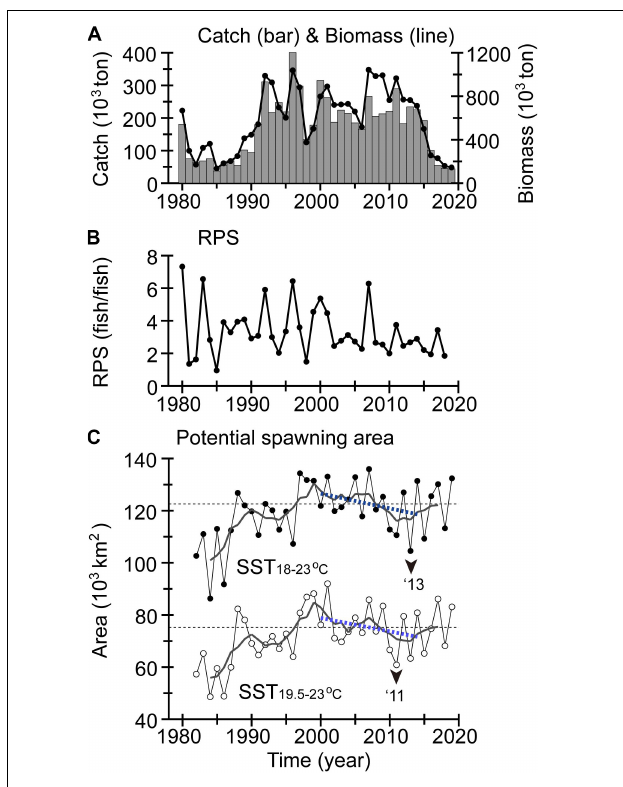
FIGURE 13 | (A) Catch (bar chart), biomass (line graph), and (B) RPS for winter spawning stock of Japanese flying squid. (C) Potential spawning area as estimated by winter SSTs of 18–23 ◦ C (closed circles) and 19.5–23.0 ◦ C (open circles) on shelves with a water depth of 100–500 m, north of the Kuroshio in the East China Sea (Rosa et al., 2011). Display style in panel (C) is the same as in Figure 5